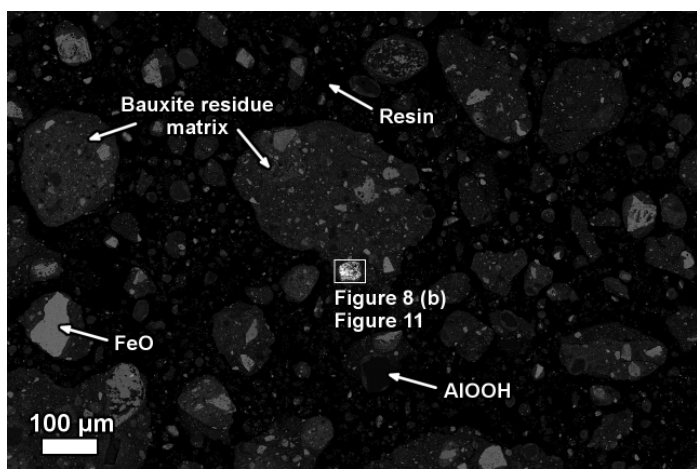
Figure 4. Backscattered electron image of bauxite residue. The bright REE particle in the middle corresponds to the particle depicted on Figures 8b and 11.